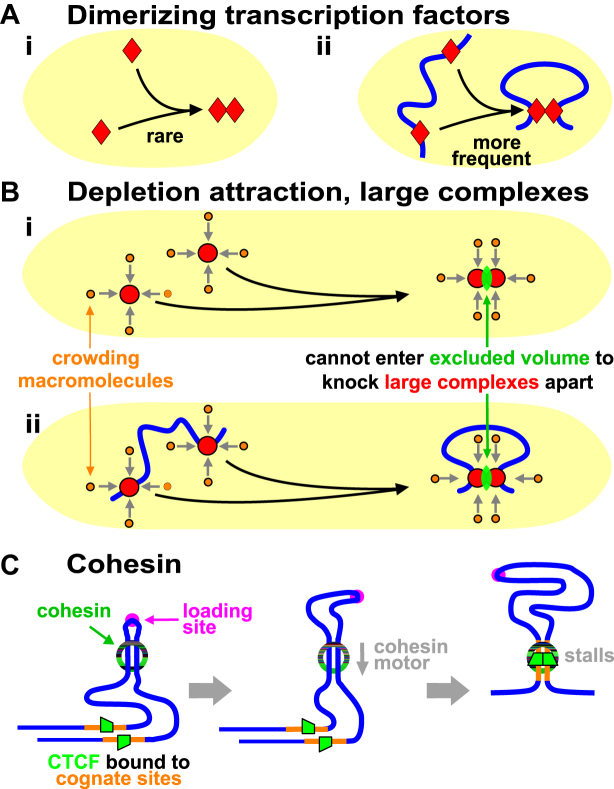
Some drivers of looping. (A) Dimerizing factors (equilibrium constant ∼10−7 M). (i) If present at a typical concentration (∼1 nM), <1% factors dimerize. (ii) Binding to cognate sites 10 kbp apart on DNA increases local concentrations, and ∼67% are now dimers stabilizing loops (21). (B) The depletion attraction. (i) In crowded nuclei, small brown molecules (diameter <5 nm) bombard (grey arrows) larger red complexes (5–25 nm). If large complexes collide, smaller molecules are sterically excluded from the green volume between the two and cannot knock them apart; consequently, small molecules exert a force on opposite sides of larger complexes keeping them together. (ii) If large complexes are bound to DNA, this force stabilizes a loop. (C) Cohesin. After loading, a cohesin ring embraces two fibers to stabilize a mini loop; this loop enlarges as the ring uses an inbuilt motor to move down the fiber until stalled by CTCF bound to convergent sites.